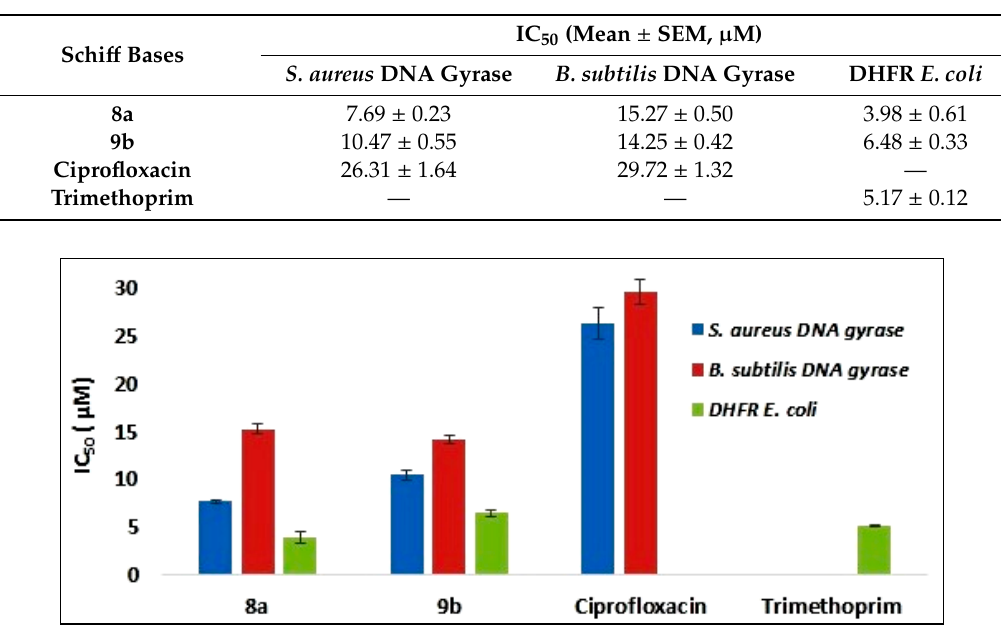
Table 8. Determination of the DNA gyrase and DHFR inhibitory activities of the most promising two Schiff bases 8a and 9b.